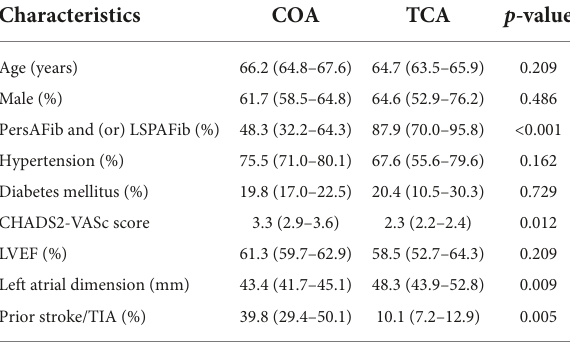
TABLE 2 Differences in characteristics between COA and TCA studies at